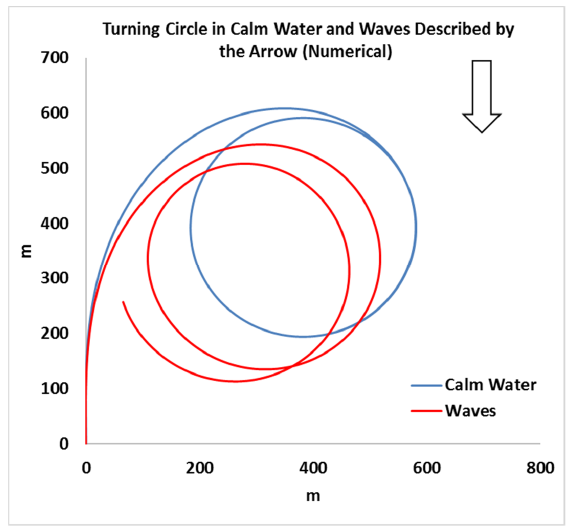
Figure 13. KCS’s numerical starboard-side 35 deg turning trajectories in calm water and regular wave with 180 deg at t = 0.